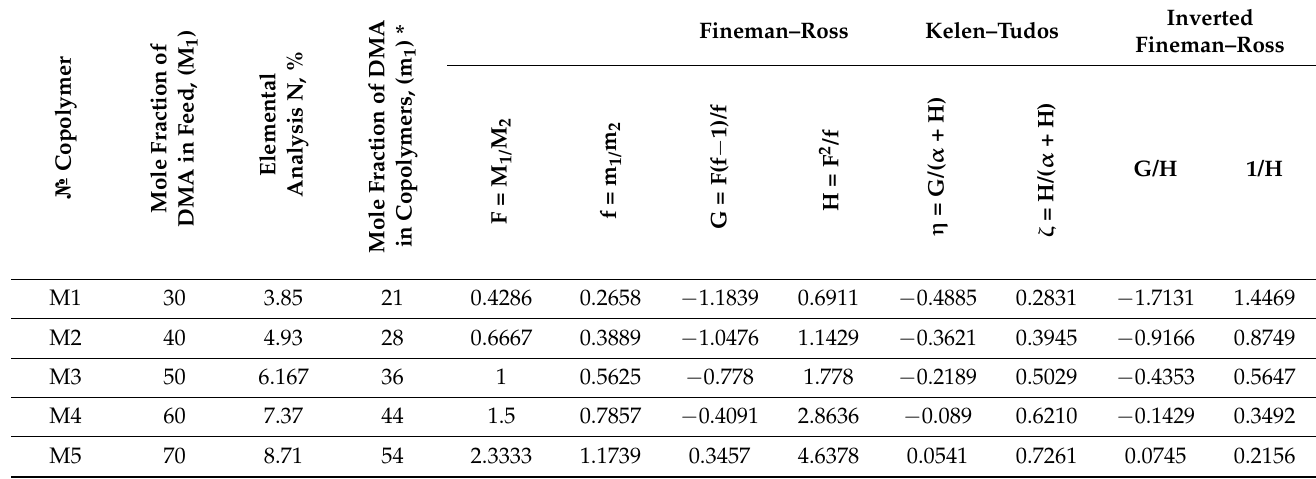
plot are given in Table 2. The molar fraction of the DMA in the copolymer versus its molar fraction in the feed is shown in Figure 4. Table 1. Determination of copolymerization reactivity ratios of DMA (r 1 ) and AAc (r 2 ) systems by Fineman–Ross, inverted Fineman–Ross and Kelen–Tudos methods.